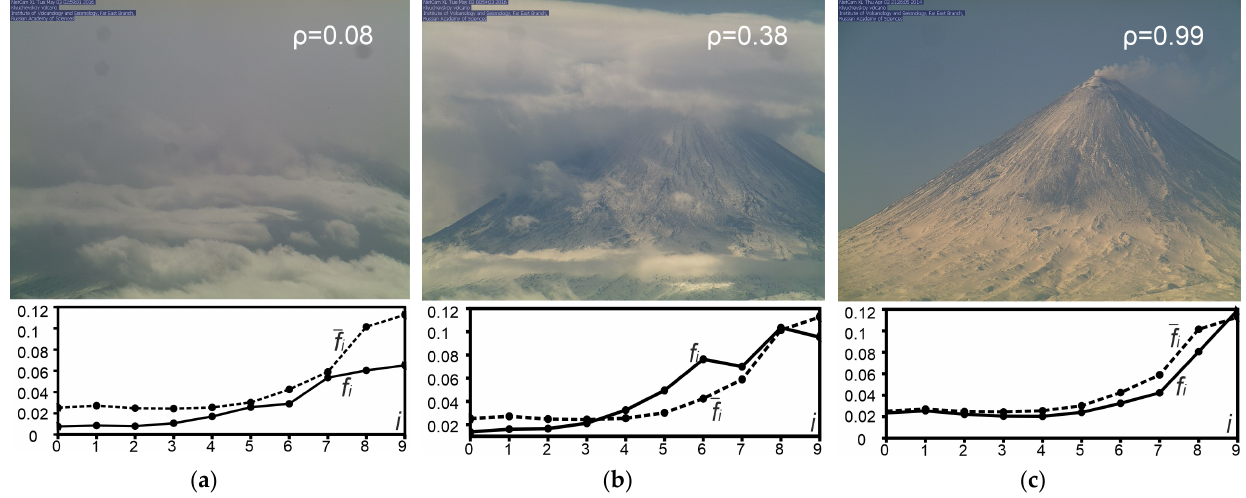
Figure 10. Graphs for frequency characteristics for different images of Klyuchevskoy volcano in compare with reference characteristics 𝐟̅ : ( a ) volcano is obscured by clouds ( ρ = 0.08 ), ( b ) volcano is partially obscured by clouds ( ρ = 0.38 ), ( c ) volcano is clearly visible ( ρ = 0.99 ).